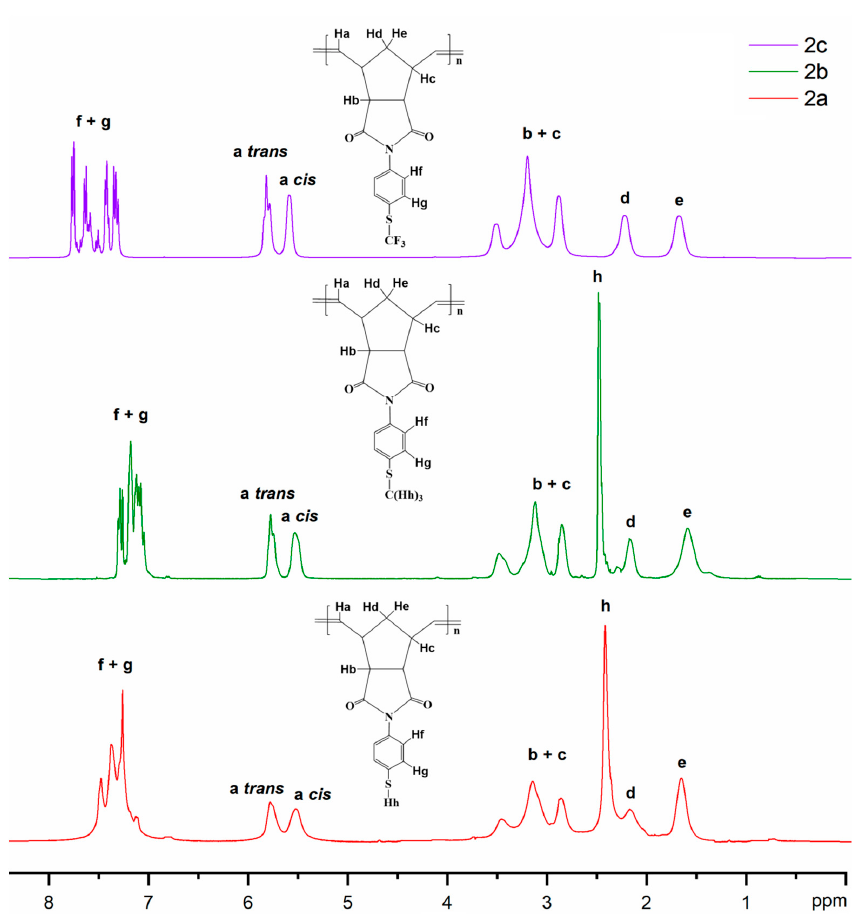
Figure 4. 1 H ‐ NMR spectra of the polynorbornene dicarboximides bearing thiol pendant groups. Figure 4. 1 H-NMR spectra of the polynorbornene dicarboximides bearing thiol pendant